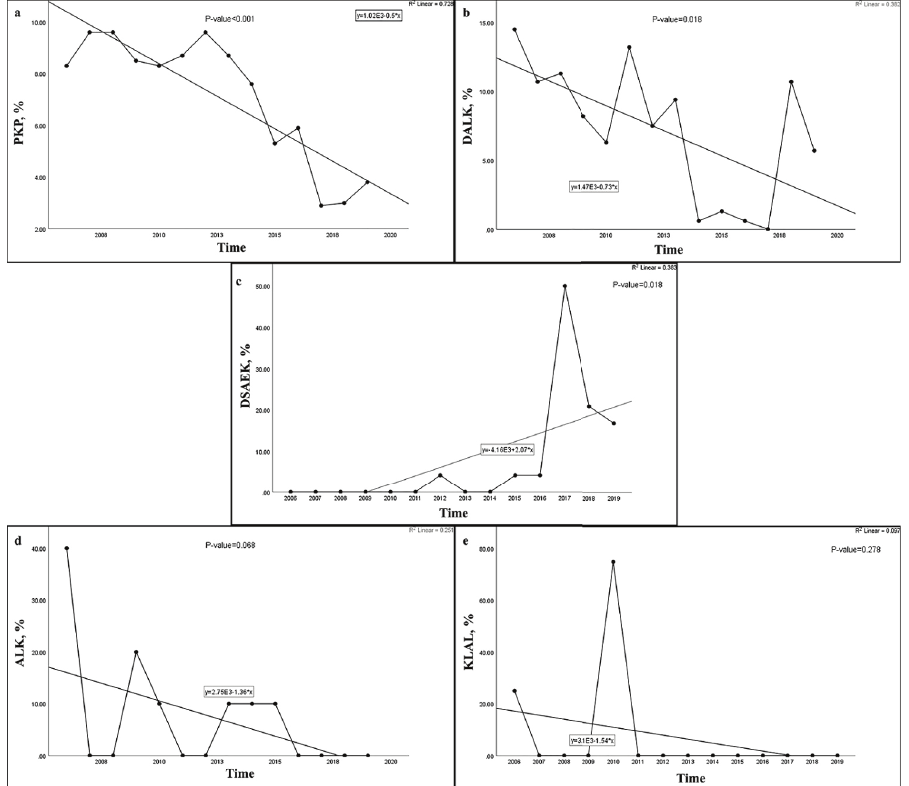
Figure 3. Trends of surgical techniques for pediatric keratoplasty in Iran between 2006 and 2019. Note the significant downward trend for PKP (a; P < 0.001) and DALK (b; P = 0.018); the remarkable ascending trend for DSAEK (c; P = 0.018); the borderline change of trend for the ALK (d; P = 0.068), and the lack of change of trend for KLAL (e; P = 0.278). PKP, penetrating keratoplasty; DALK, deep anterior lamellar keratoplasty; DSAEK, Descemet stripping automated endothelial keratoplasty; ALK, anterior lamellar keratoplasty; KLAL, keratolimbal